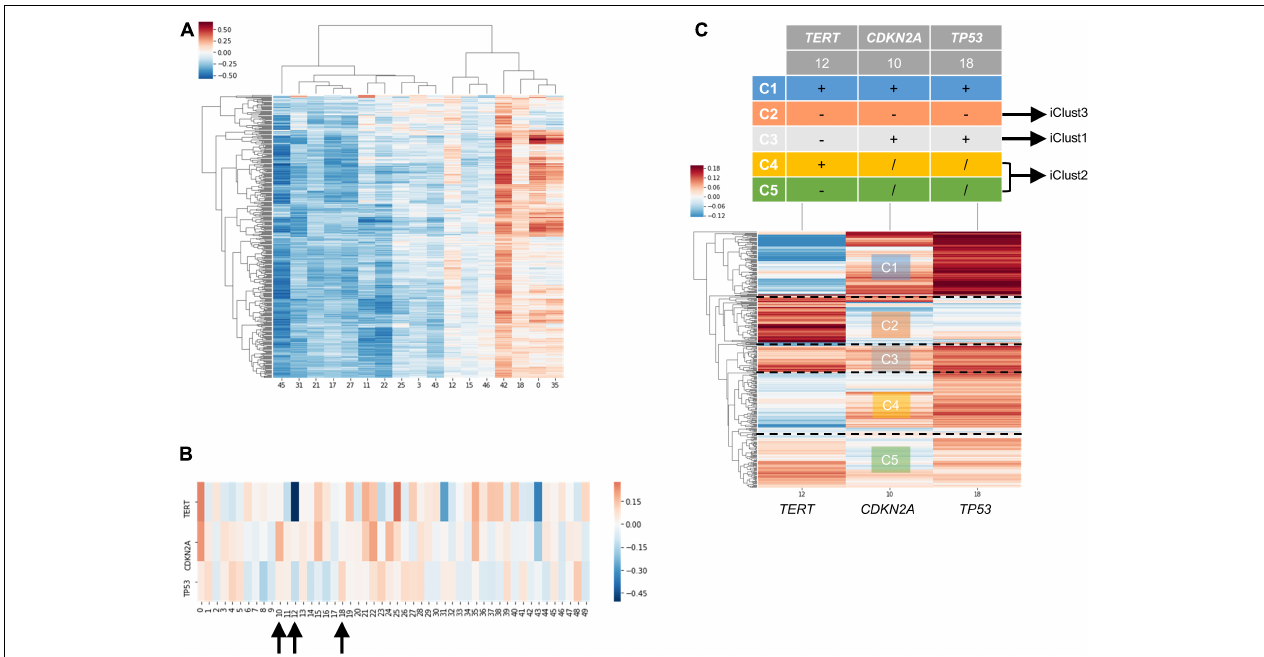
FIGURE 4 | Molecular subtyping of liver hepatocellular carcinoma/LIHC using entity matrix. (A) Heatmap of LIHC dataset with respect to entity dimensions, only dimensions with stand deviation larger than mean stand deviation were shown. (B) Heatmap of three signatures genes, TERT , CDKN2A , and TP53 which were previously reported to distinguish liver cancer subtypes, with respect to entity dimensions. Dimension 10, 12, 18 corresponded to TERT , CDKN2A , and TP53 , respectively. (C) Heatmap of LIHC dataset with respect to entity dimension 10, 12, and 18 showed five distinct clusters labeled as C1-C5. C3, C4&C5, and C2 matched with iClust1, iClust2, and iClust3,